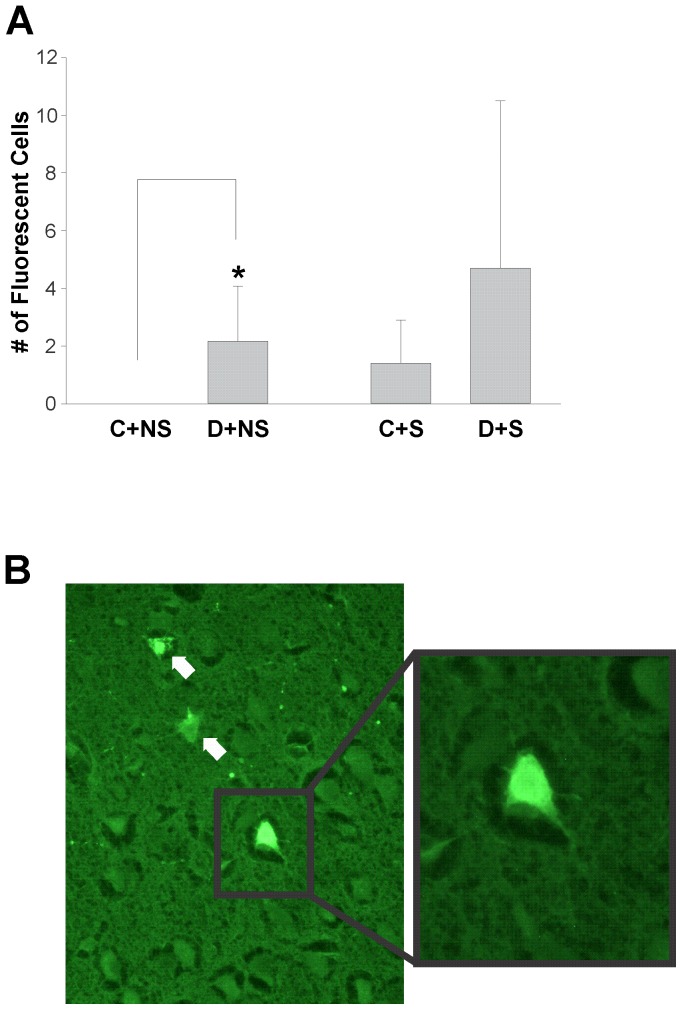
Effects of diabetes and seizures on neuronal damage.
A: Significant difference in the number of fluorojade (+) cells between CON non-seizing (C+NS: 0±0; n = 5 animals) and STZ non-seizing groups (D+NS; 2.17±1.9 cells; n = 6; p<0.05). No significant difference in the number of cells between CON seizing (C+S: 1.4±1.5; n = 5 cells) and STZ seizing groups (D+S: 4.7±5.8 cells; n = 7) B: Fluorojade (+) cells in the cortical region of (D+S) rat magnified 40X (white arrows).